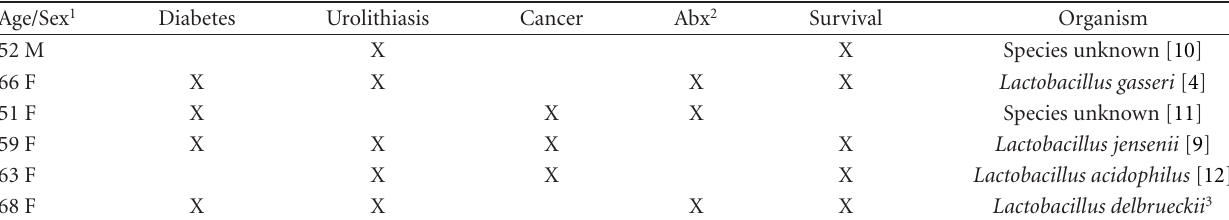
Table 1: Cases of Lactobacillus bacteremia from a renal